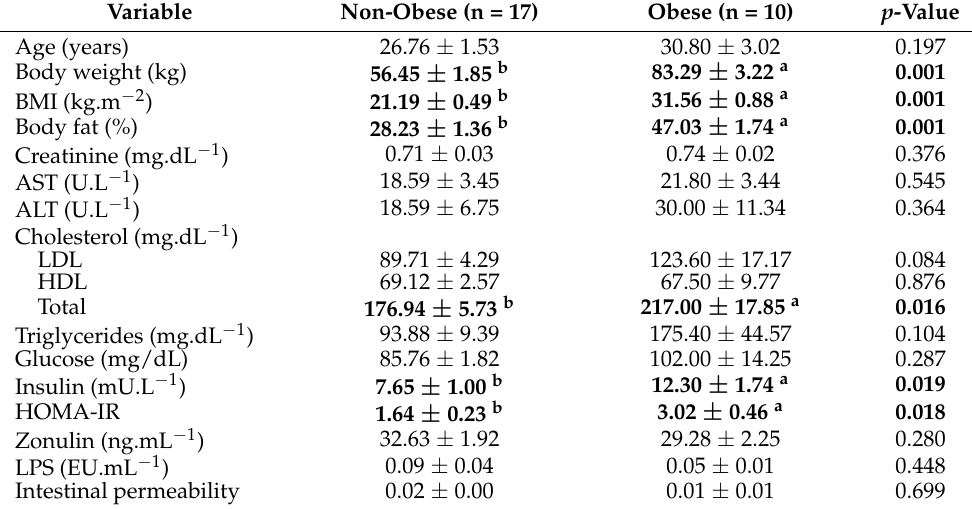
Table 1. Anthropometric variables, biochemical parameters, and intestinal permeability markers of the non-obese and obese